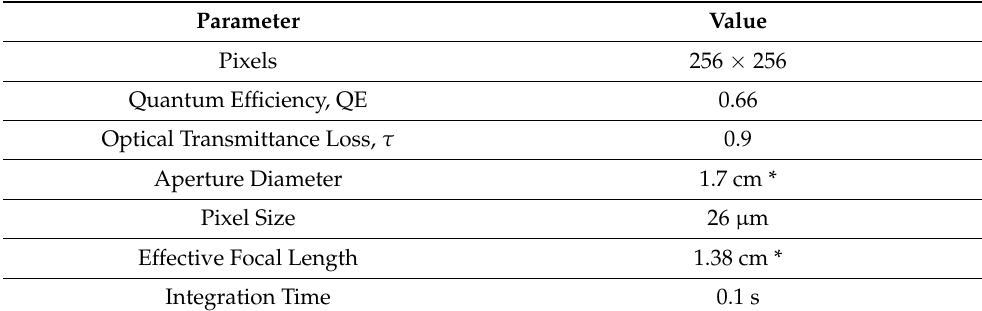
Table 1. Fast Aurora Imager Parameters